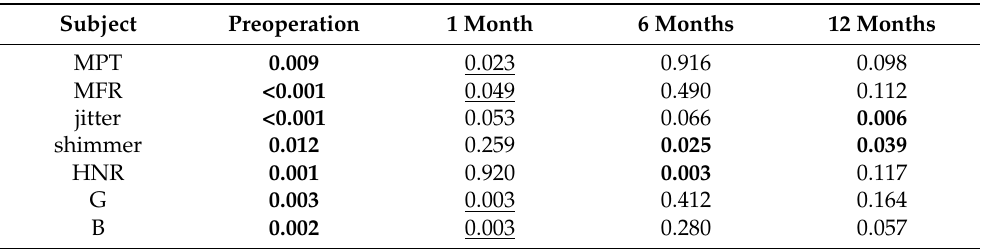
Table 6. p values of each parameter and period in comparison between paralyzed-reconstruction subgroup and phonosurgery